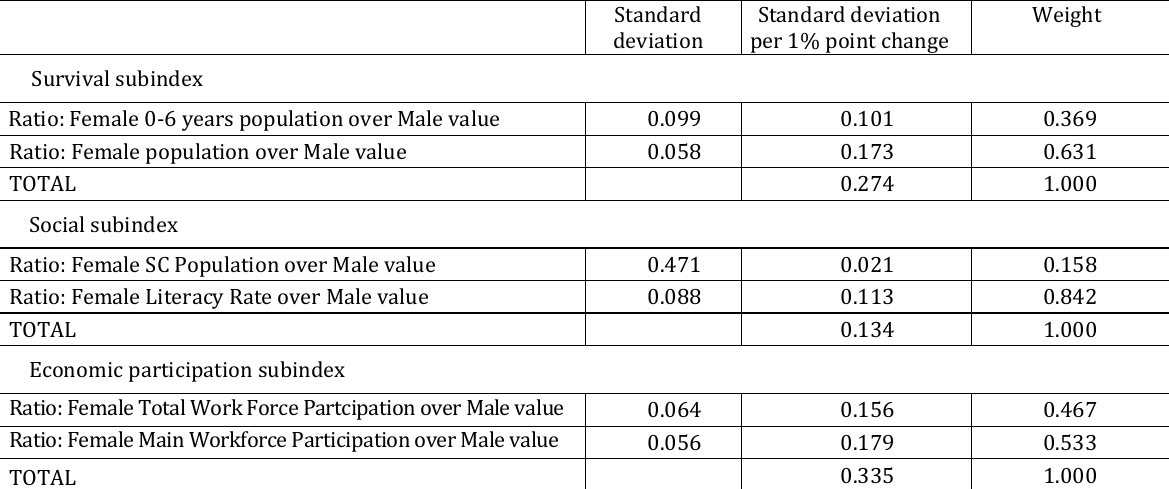
Table 2. Weights for indicators and Subindices, Gender Gap Index, Sehore M.C.